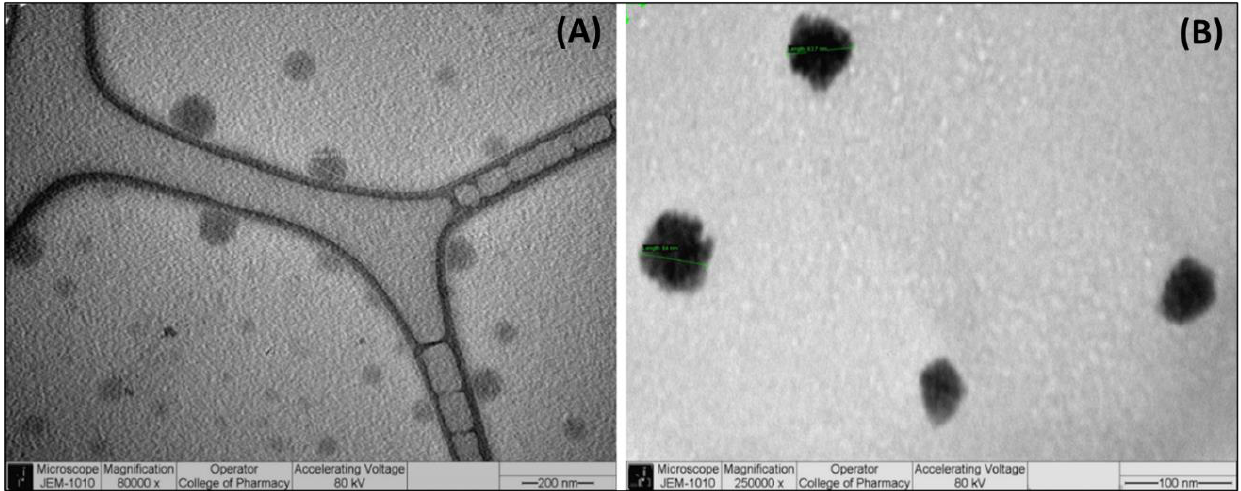
Figure 3. TEM images showing the structure and shape of the droplet sizes of the SNEDDSs at ( A ) 80,000× and ( B ) 250,000× magnifications.